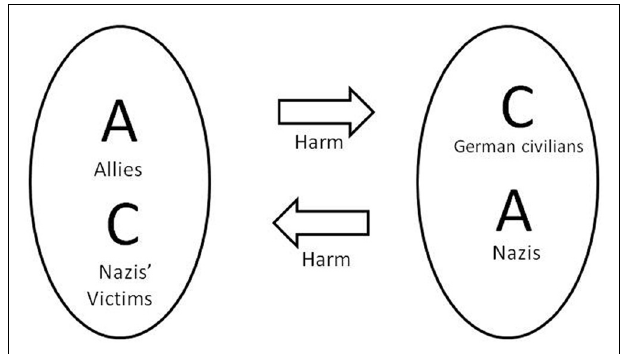
FIGURE 4 | Representation of difficult moral judgment. In many difficult moral judgments, such as the bombing of civilians in Dresden inWorldWar II, or the use of harsh methods of interrogation against terrorists, the victims are associated with the perpetrators and the perpetrators are associated with the victims.This induces a strong competition between perpetrator–victim category nodes making it difficult to reach a final